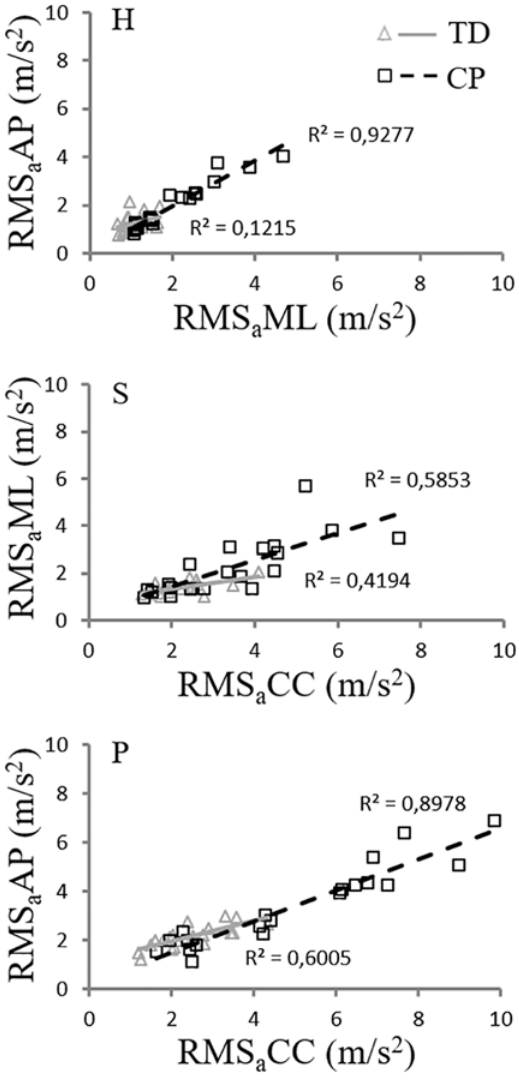
Fig 3. RMS a inter-component relationships for the two groups (TD in light grey and CP in black). The inter-component comparison graphs characterized by significant different regression lines between the TD and CP groups are reported in figure: RMS a AP vs RMS a ML for head (p = 0.007), RMS a ML vs RMSaCC for sternum (p = 0.048), and RMS a AP vs RMSaCC for pelvis (p =